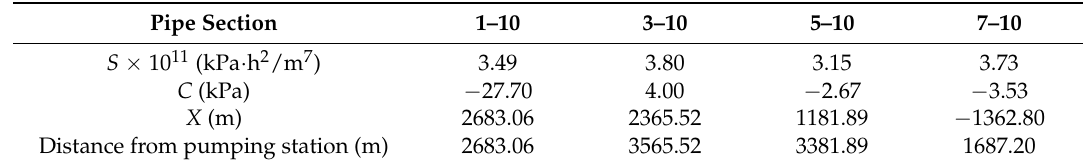
Table 3. Estimated burst point.